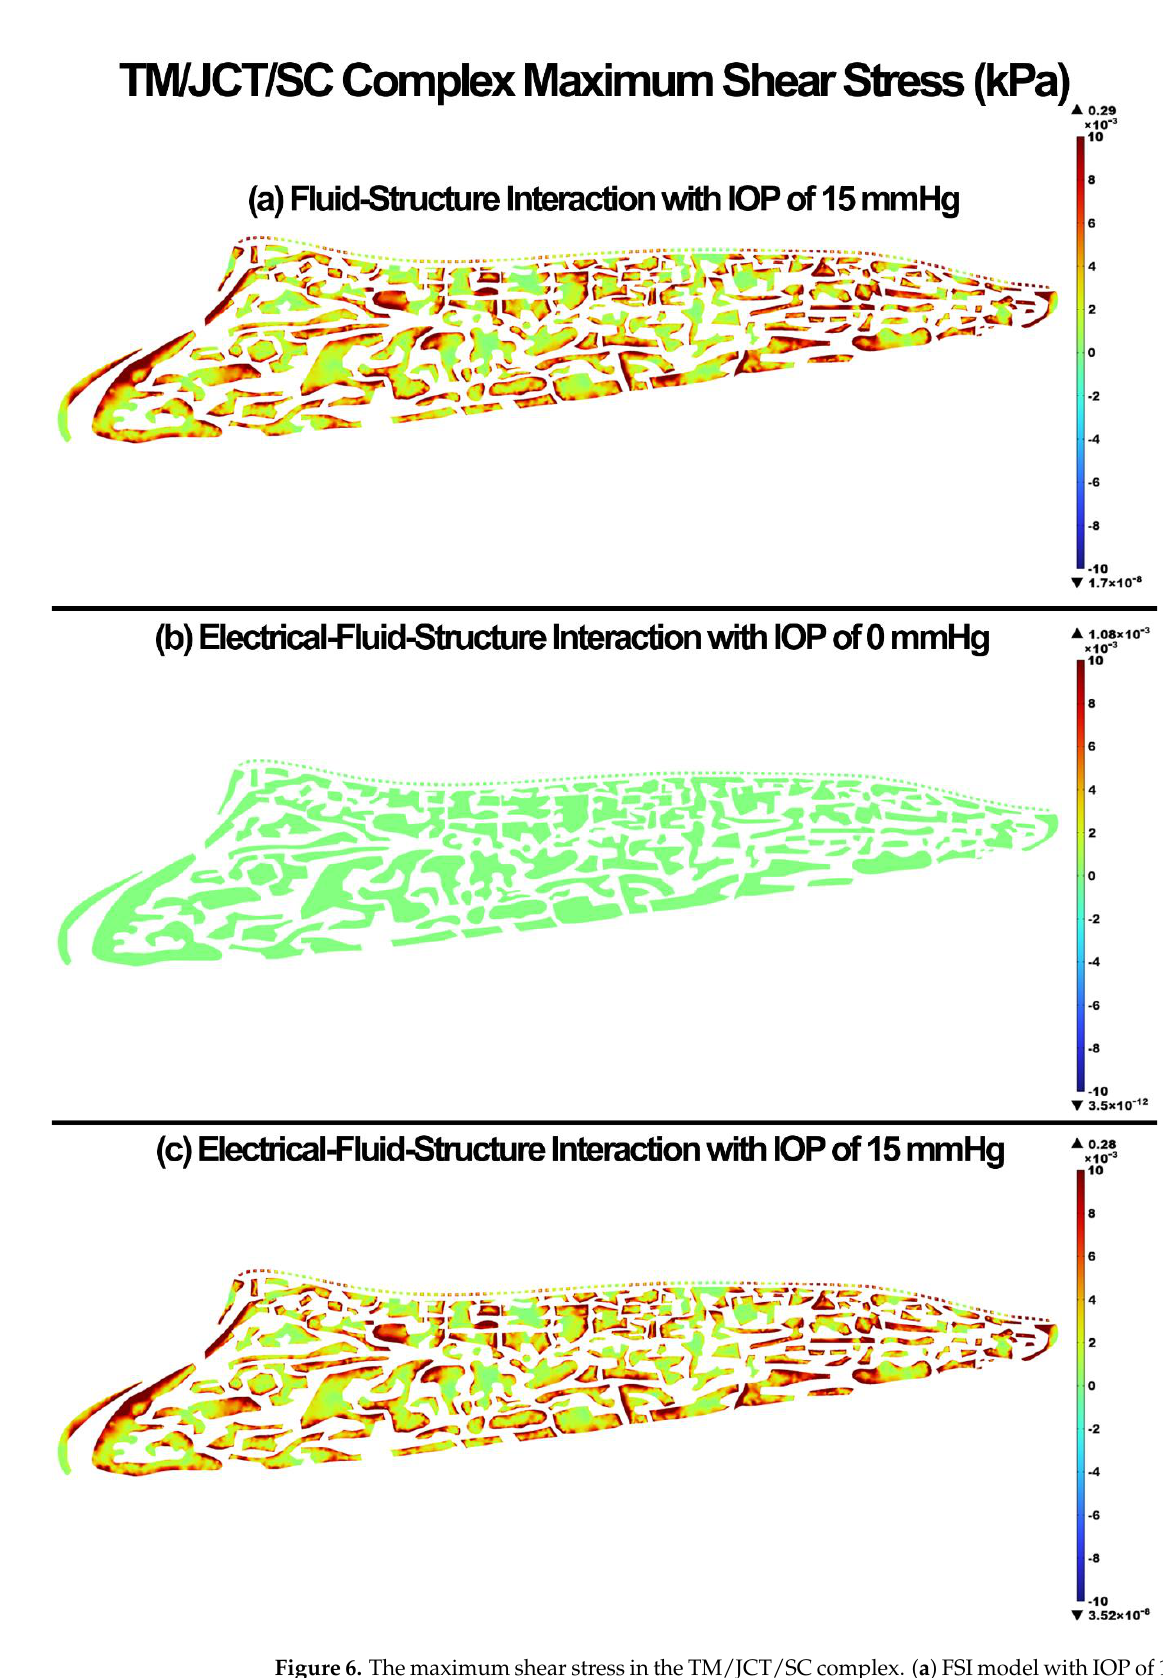
Figure 6. The maximum shear stress in the TM/JCT/SC complex. ( a ) FSI model with IOP of 15 mmHg, ( b ) EFSI with IOP of 0 mmHg, and ( c ) EFSI with IOP of 15 mmHg.